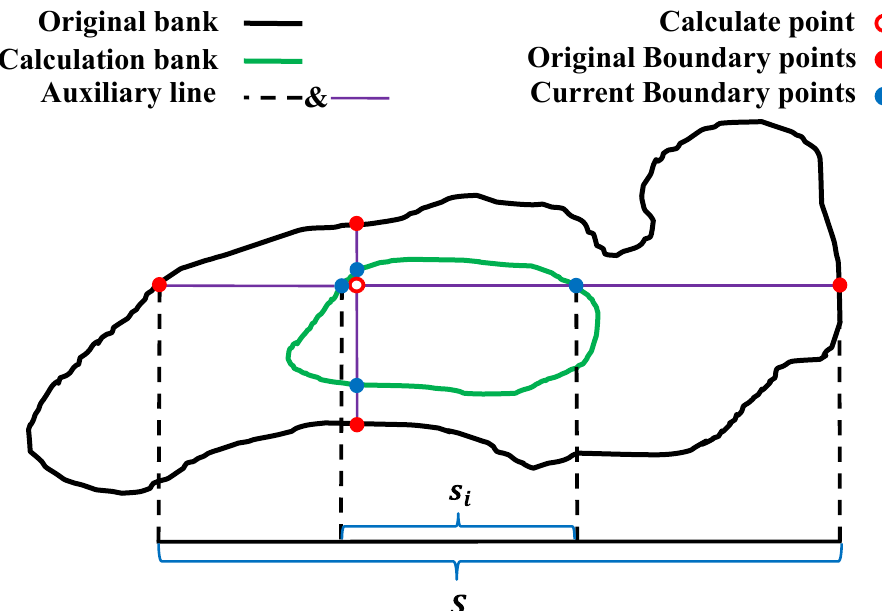
Figure 3. Model calculation procedure diagram. The black line represents the original bank of the lake, and the green line represents the calculated bank of the lake. The red circle is the current calculated pixel, and the red / blue solid dots represent the linked original / current boundary points. S and s i represent the original and current calculation widths, respectively, which can be shown in the profile in Figure 5.